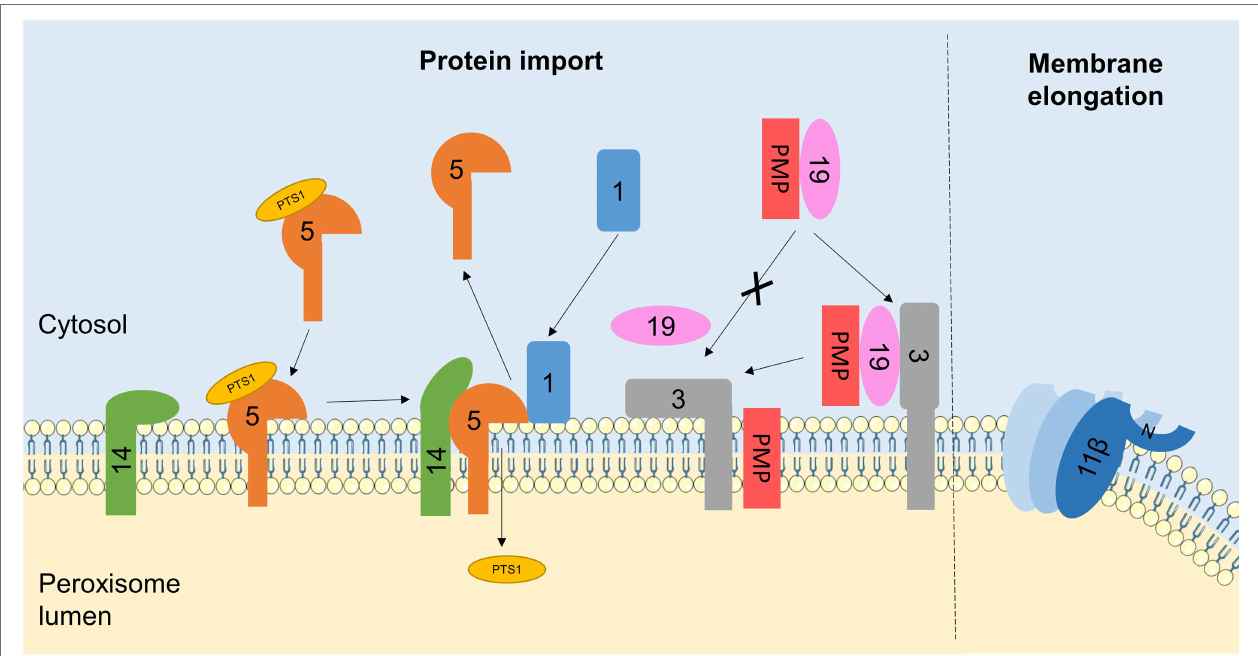
FIGURE 3 | Interactions between PEX proteins and peroxisomal membrane lipids. Schematic of protein-lipid interactions regulating peroxisome biogenesis. For simplicity, PEX proteins are referred to by number only (with the PEX omitted). Interactions of PEX proteins with lipids in the peroxisomal membrane regulates PMP and matrix protein import. PEX1 recruitment to the membrane is facilitated by its binding to phosphoinositides. PEX1 is required for the recycling of the matrix protein receptor PEX5, which is itself stabilised by interactions with membrane lipids. The N-terminus of PEX14, part of the membrane docking complex for PEX5, can also bind to peroxisomal lipids, possibly to hide its PEX5-interacting face in the absence of PEX5, preventing non-specific binding to other cytosolic proteins. The PMP receptor PEX3 also interacts with lipid bilayers mimicking the peroxisomal membrane, which may serve to destabilise the membrane and release the chaperone PEX19, allowing for PMP insertion. Additionally, the interaction of PEX11 β with the peroxisome membrane is important for its role in membrane elongation. Insertion of an amphipathic helix at the N-terminus of PEX11 β into the lipid bilayer, as well as PEX11 β oligomerisation, is required for membrane tubulation. Elements of figure taken from Servier Medical Art